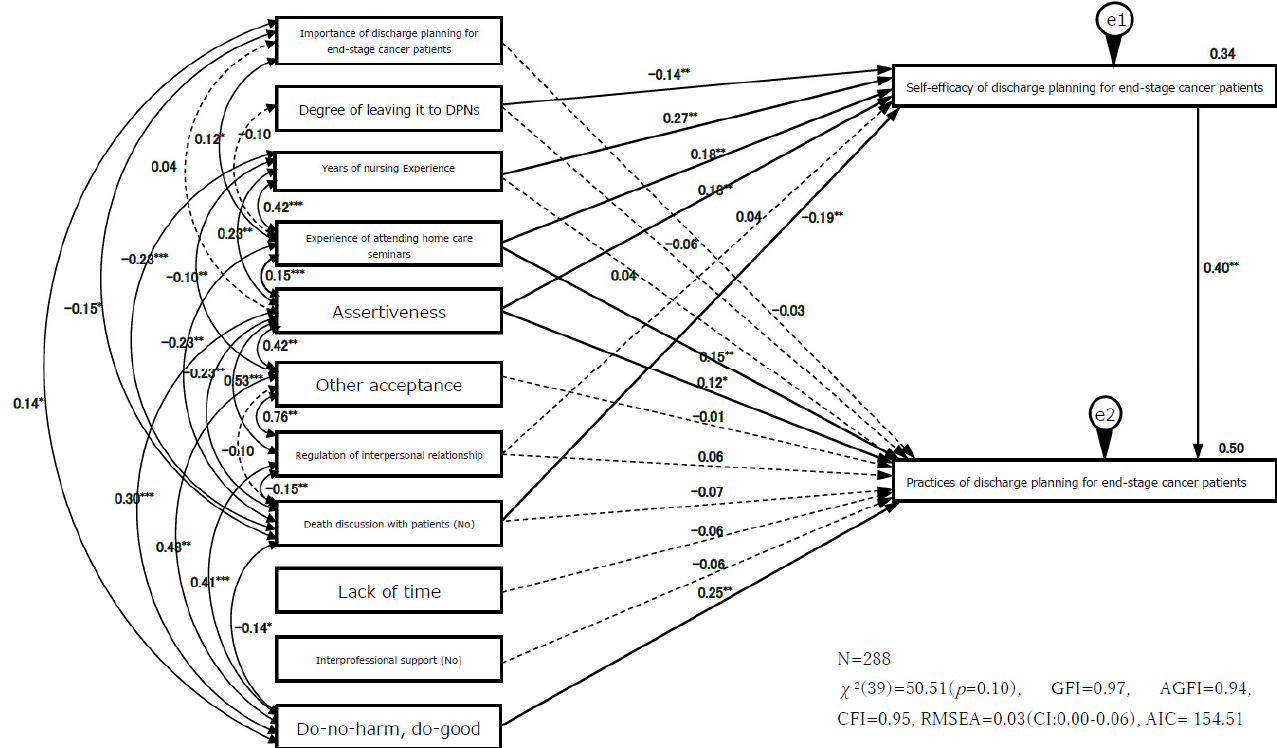
Figure 2. Path analysis of hypothesized model. Note: Dotted line is nonsignificant path, *: p < 0.05, **: p < 0.01, ***: p < 0.001. **: p < 0.01, ***: p <